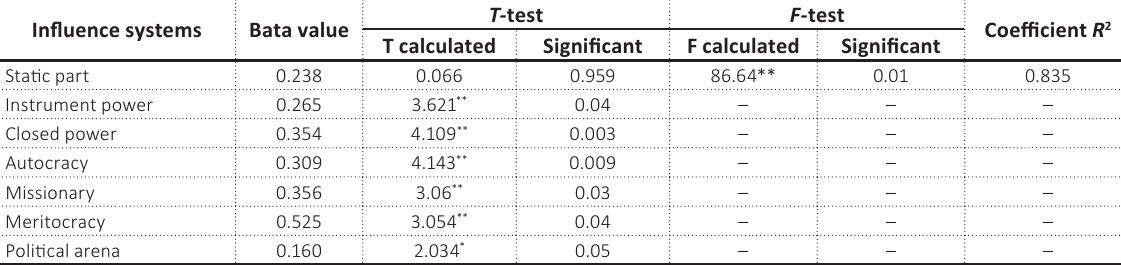
Table 5. Effect of organizational power systems on strategy determination methods Influence systems